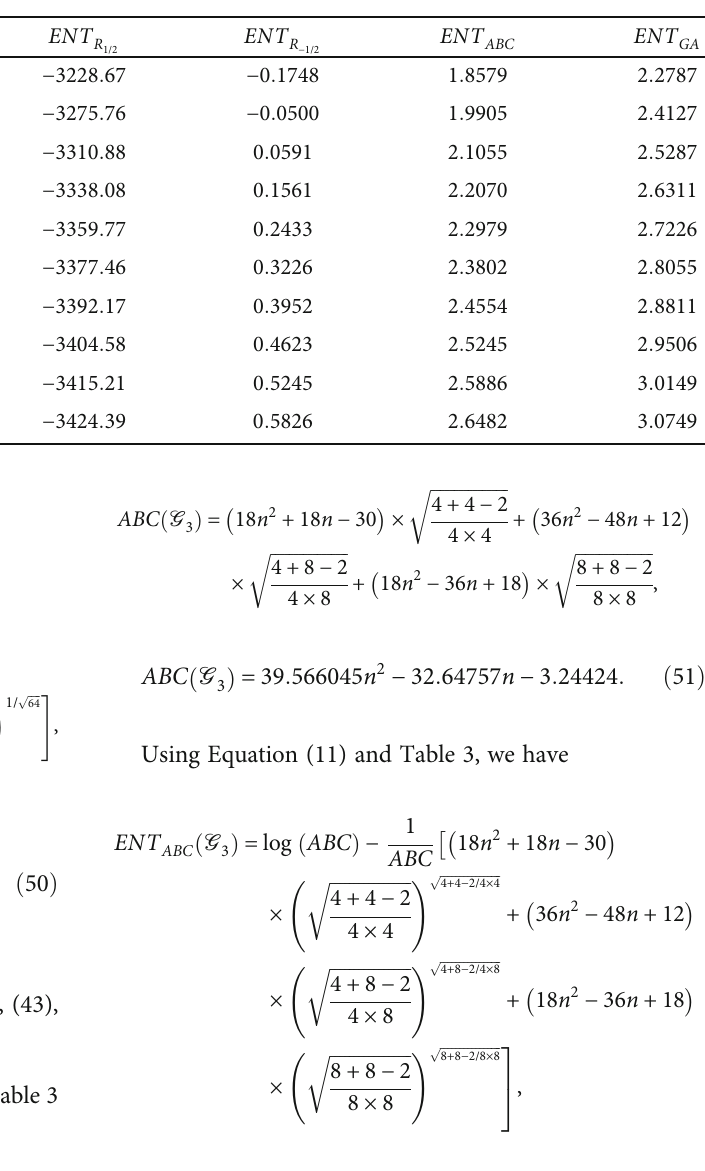
Table 5: Comparison table of entropies for TP ð n Þ